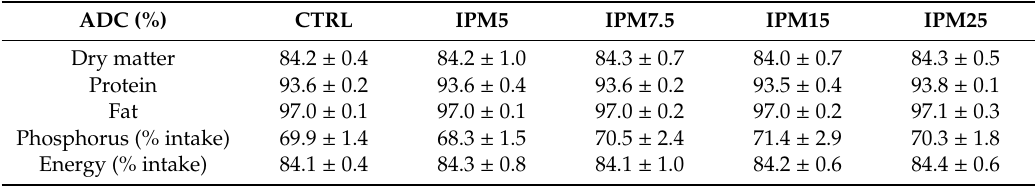
Table 5. Apparent digestibility coe ffi cients (ADC) of nutrients and energy in rainbow trout fed the five experimental diets (Control: CTRL, and experimental diets with 5%, 7.5%, 15%, or 25% insect protein meal (IPM), respectively IPM5, IPM7.5, IPM15, and IPM25). Values are means ± standard